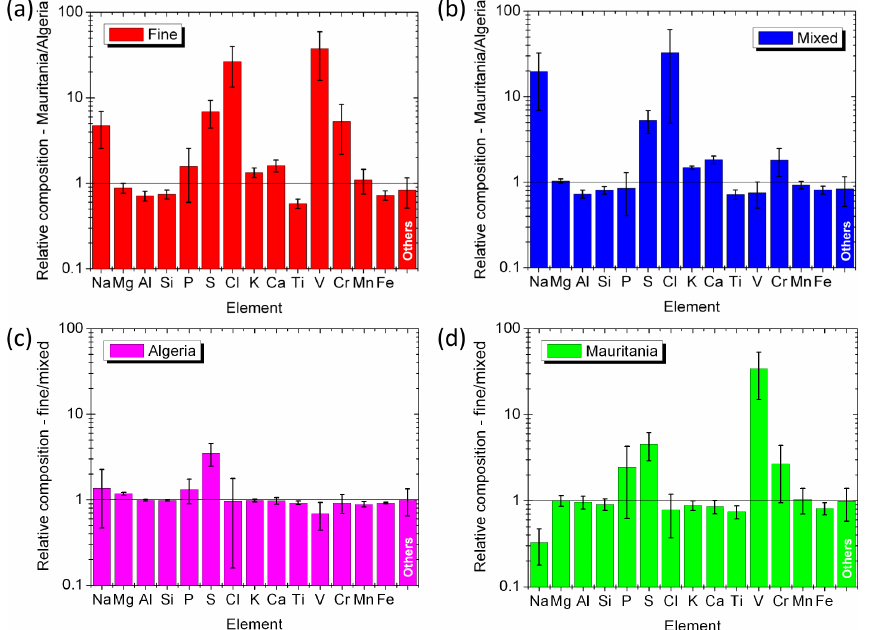
Figure 12. Relative elemental composition in logarithmic scale for each element between different sites – (a) fine mode and (b) mixed mode – and between different modes in the same site – (c) Algeria and (d) Mauritania – obtained by energy dispersive X-ray fluorescence analysis